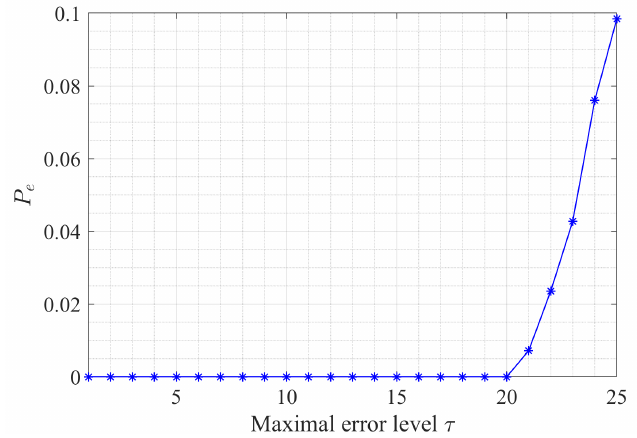
Figure 4. Probability P e versus the maximal error